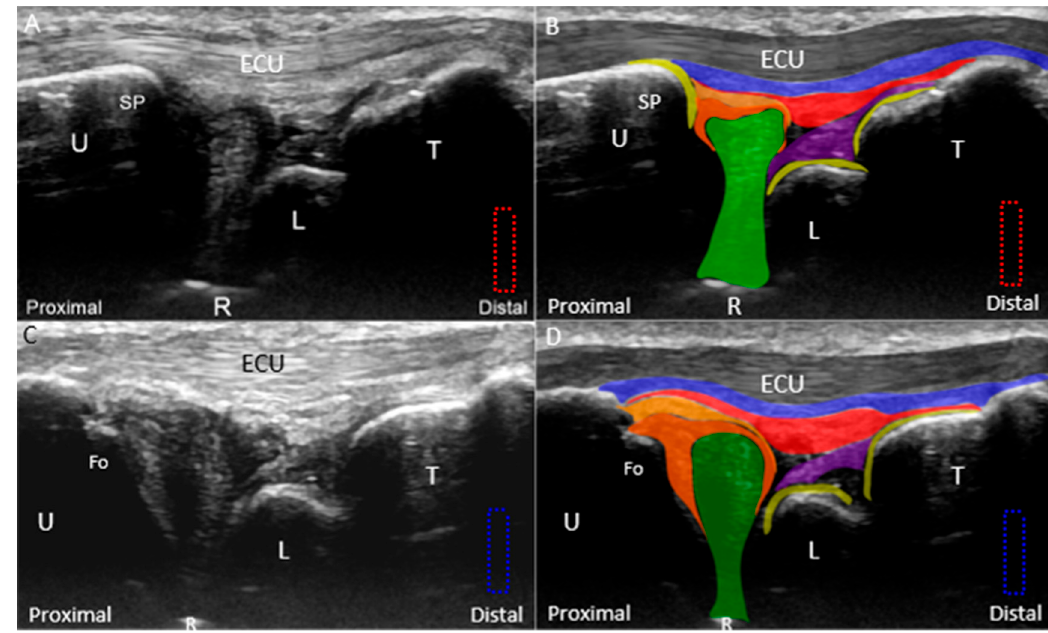
Figure 4. ( A ) Ultrasound (US) imaging of the triangular fibrocartilage complex (TFCC) using the long-axis approach; ( B ) superposed schematic drawing; ( C ) US imaging of the TFCC near the ulnar fovea using long-axis approach; and ( D ) superposed schematic drawing. The different color dashed rectangles are in accordance with the transducer positions in Figure 3. US: ultrasound; U: ulna; R: radius; L: lunate; T: triquetrum; SP: styloid process; Fo: fovea; ECU, extensor carpi ulnaris; TFCC: triangular fibrocartilage complex. Superficial limb of the radioulnar ligament (light brown shade) , deep limb of the radioulnar ligament (dark brown shade) , articular disc (green shade) , ECU tendon (grey shade) , ulnar collateral ligament (blue shade) , meniscus homologue (red shade) , lunotriquetral ligament (purple shade) , and cartilage (yellow shade) .